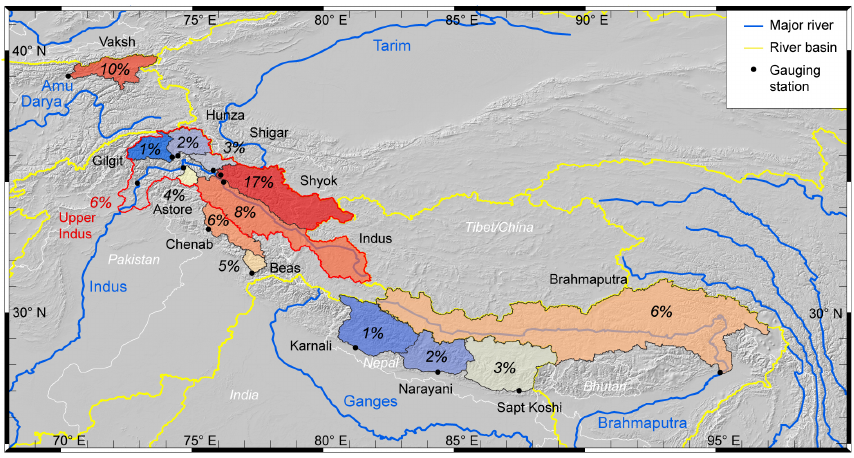
Figure 2. The percentage of discharge equivalent from annual glacier imbalance to measured average river run-off for selected catchments. Note that the actual numbers will be somewhat lower due to unaccounted water losses such as from evaporation or to groundwater. For details on the gauging stations used and the uncertainty of the contributions see the